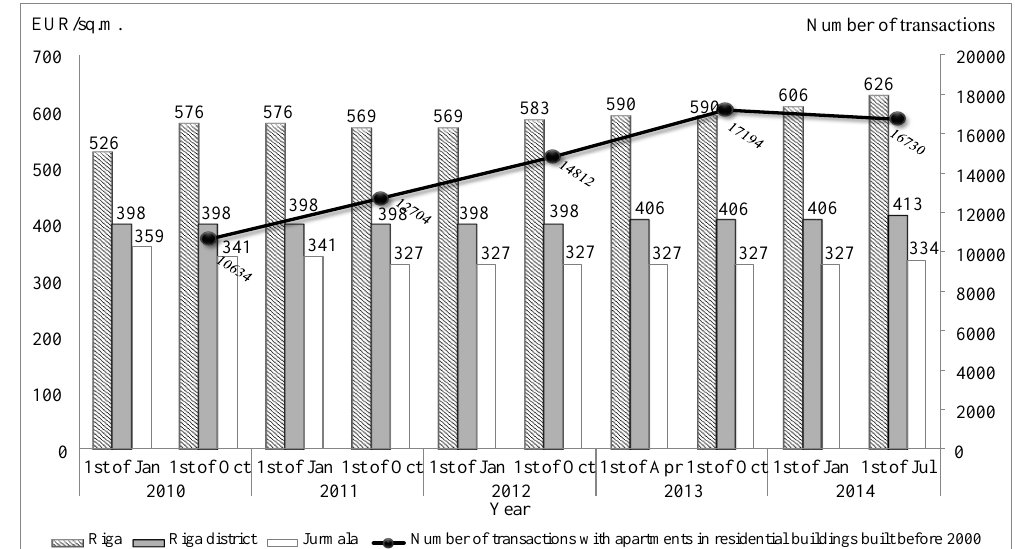
Fig. 6. Average market value of apartments in serial type residential buildings in Riga districts, Riga region and the city of Jurmala according to the data provided by Ltd. Latio (Latio, 2015) and on the basis of the SLS information on the dynamics of transactions with apartments in serial type buildings (VZD, 2015 b ) [Figure made by the